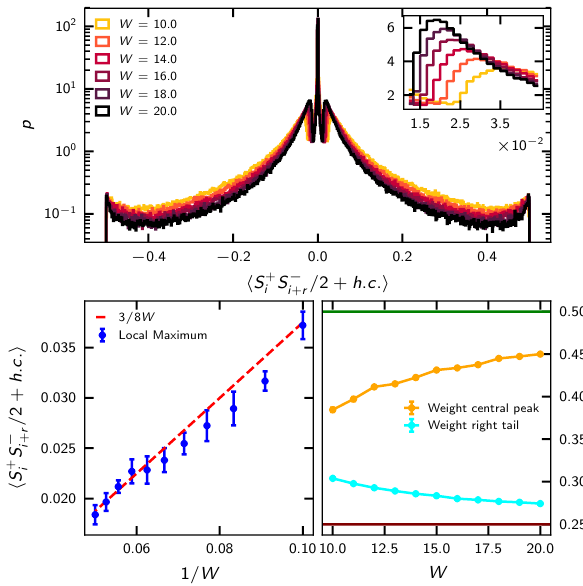
/ 2 + h . c . 〉 at large disor- S − Figure 5: Upper panel: distribution of matrix element 〈 S + i + 1 i der strength W ≥ 10, in the upper right corner the local maximum of the distributions is highlighted. Lower left panel: position of the local maximum as function of the disorder strength. The red dashed line is the exact maximum location extracted from first order perturbation theory and given in Eq. 6. Lower right panel: weight of the (cid:82) ε (cid:82) 0.5 distribution at central peak d x p ( x ) and weight of the right tail d x p ( x ) as − ε ε function of disorder strength and ε = 0.01. The weight of the peak at zero tends to 1 for strong disorder as predicted by perturbation 2